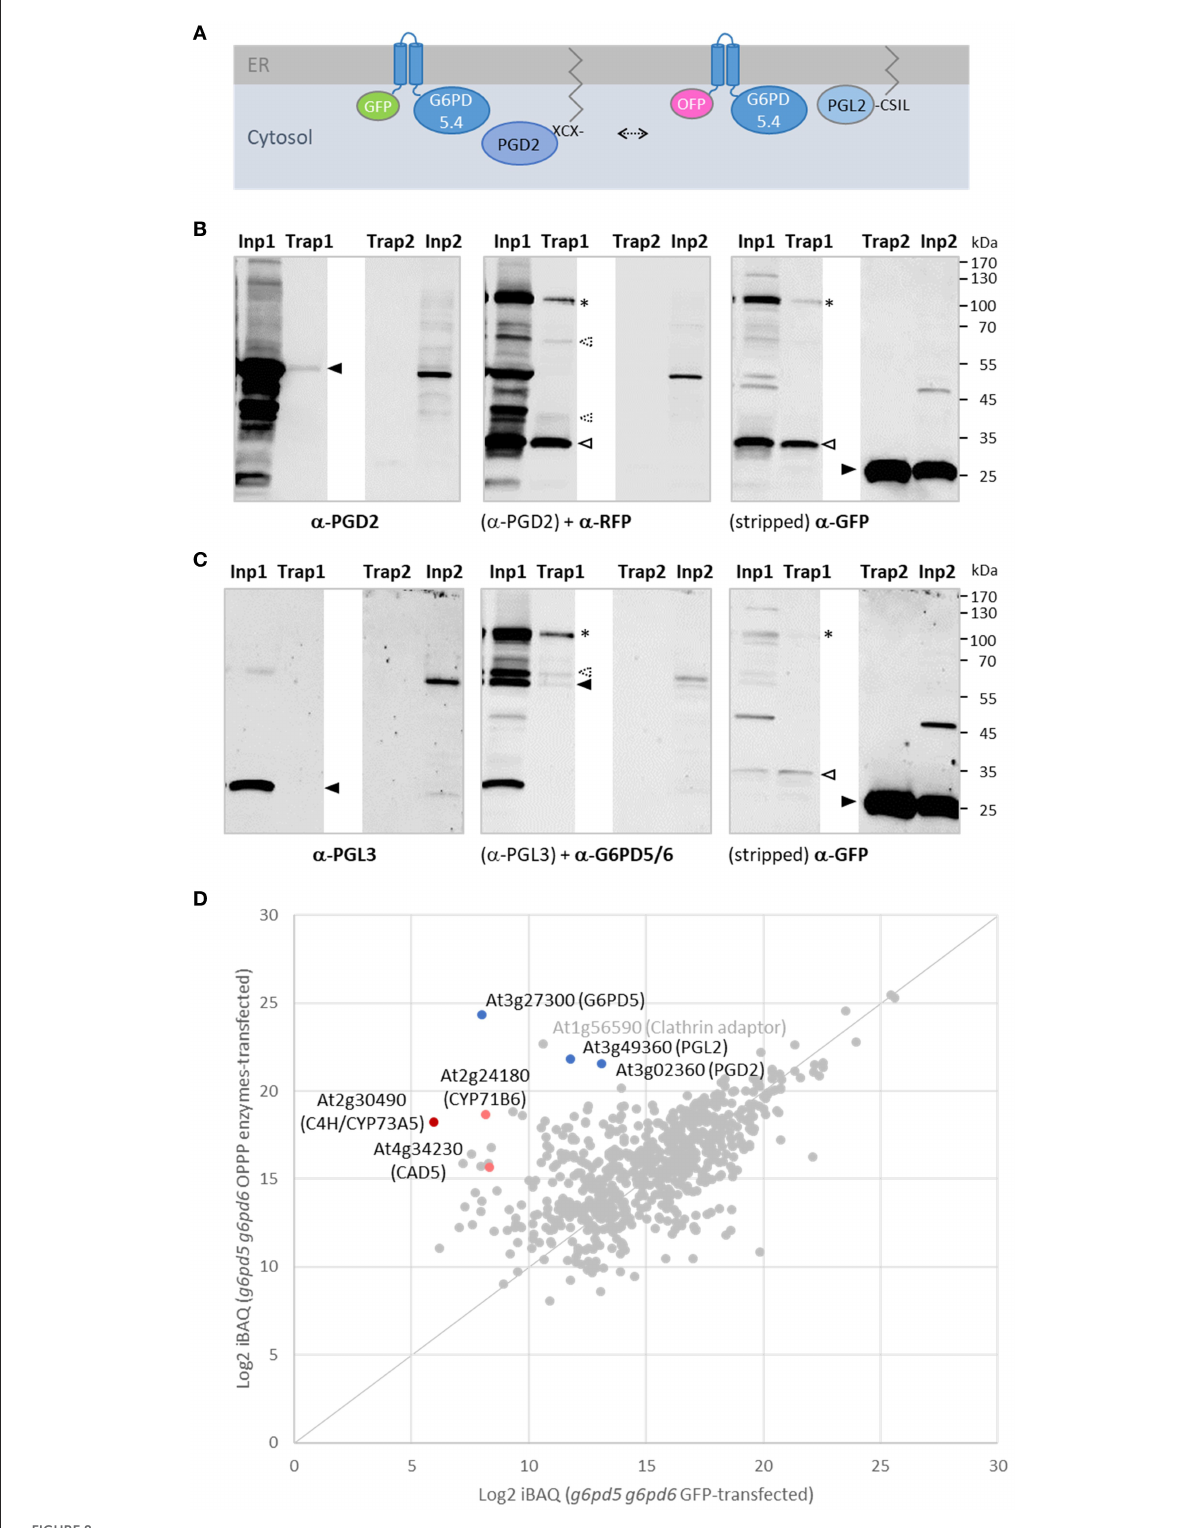
FIGURE8 GFP-based pull-down of G6PD5.4 from cells co-expressing label-free OPPP isoforms PGD2 and PGL2. To test whether also PGD2 may associate with G6PD5.4, a reporter-less expression cassette (“naked” PGD2) was introduced into the GFP-G6PD5.4 construct and